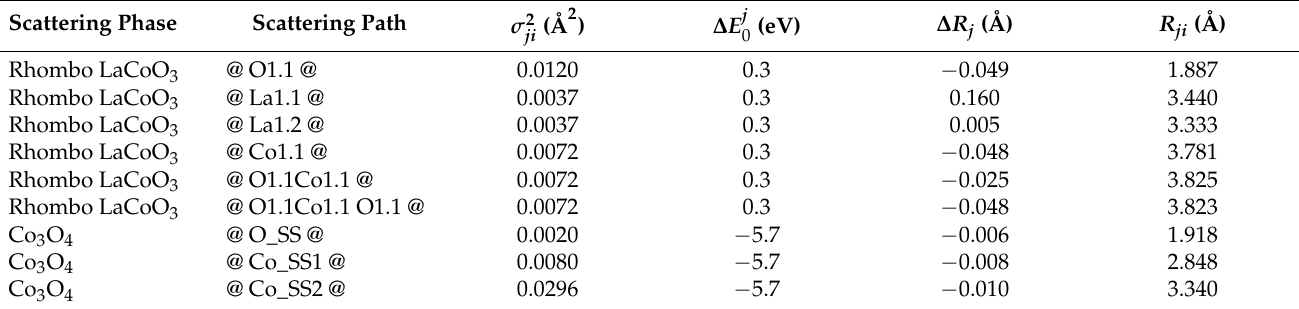
= 1 (Rhombo = Rhombohedral). 0